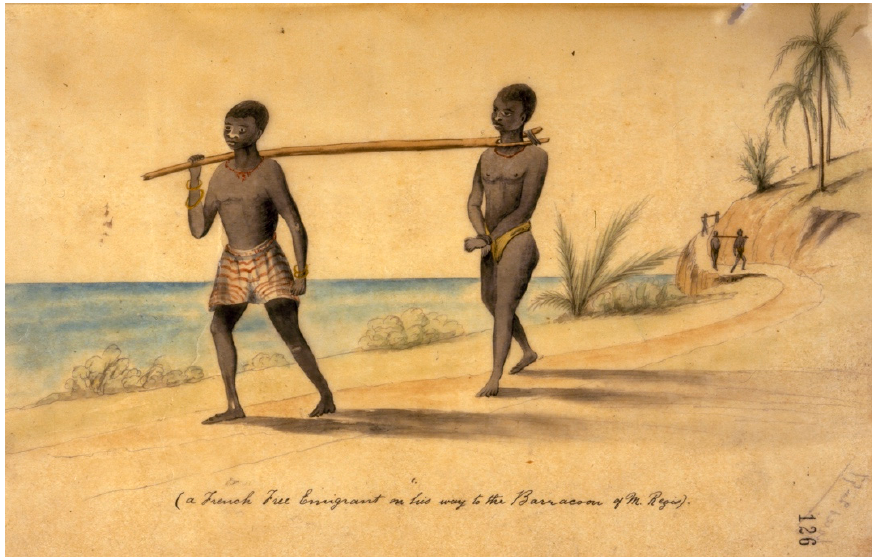
Figure 15. “French free emigrant on his way to the Barracoon of M. Regis.” A drawing made by Lt. Henry Hand of the British Navy that accompanies a letter to his commanding officer (8 September 1858). Image courtesy of The National Archives, London, (FO 84/1070).